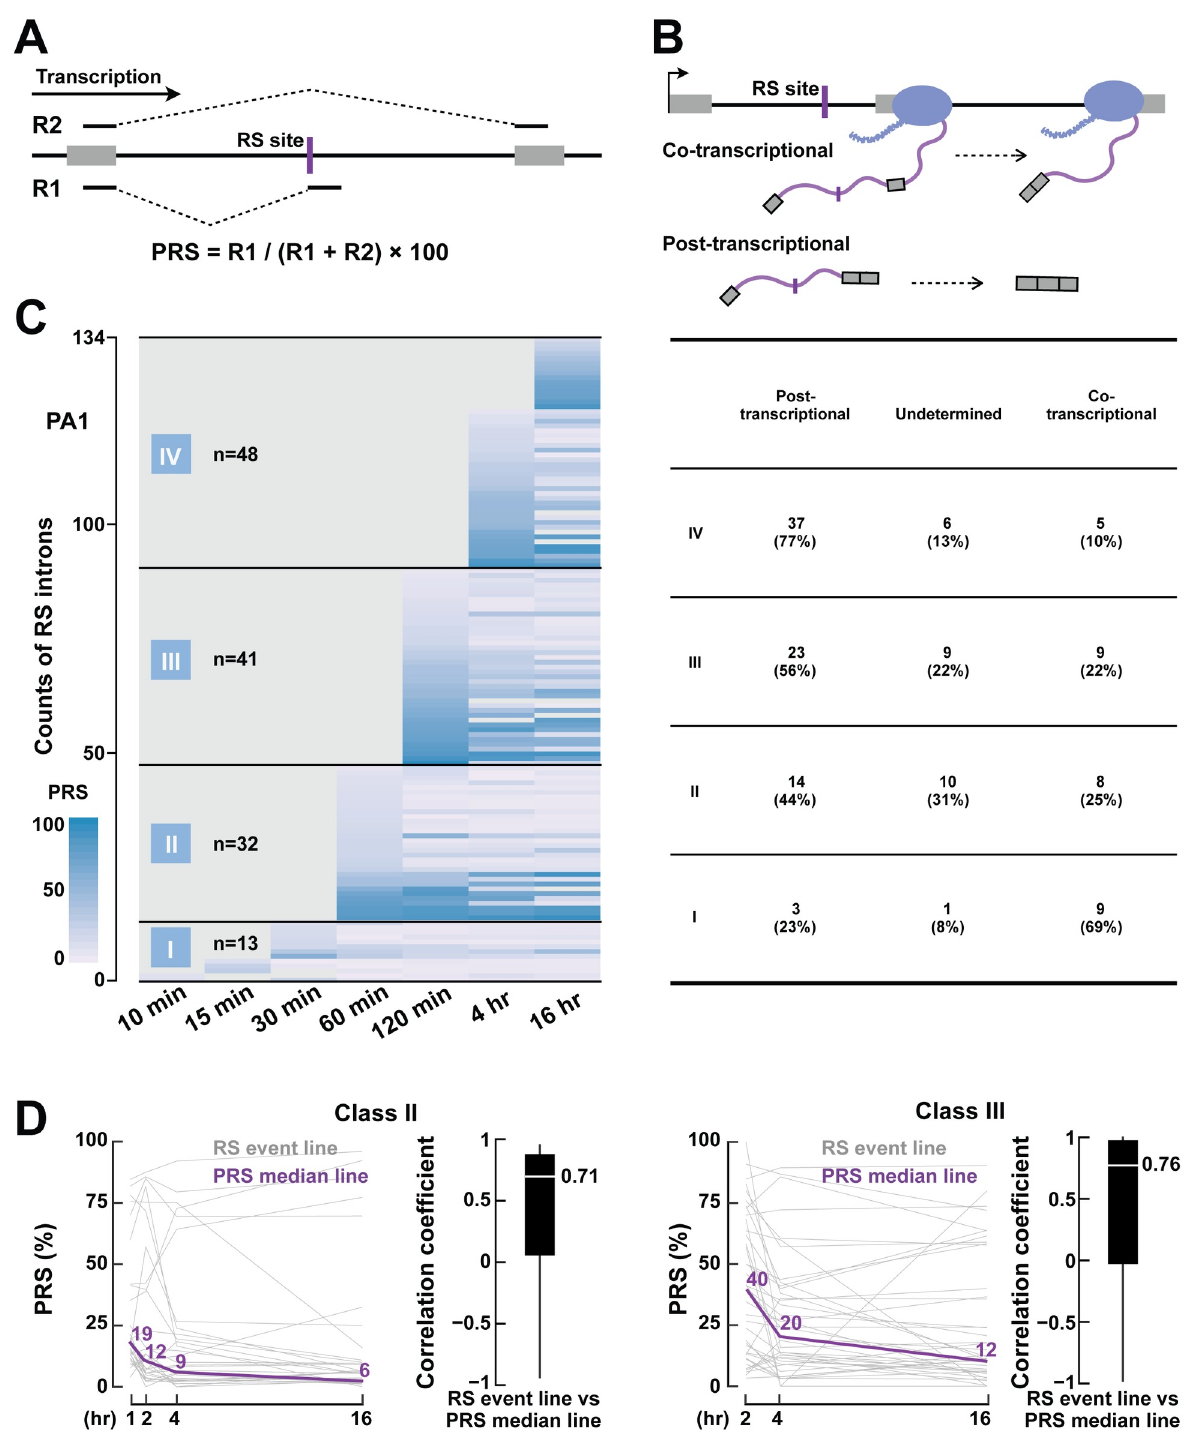
Fig 4. Recursive splicing occurs with a delay after transcription. (A) Percent Recursive Splicing (PRS) is defined as the percentage of junction reads that support the intermediate product of recursive splicing. (B) A schematic diagram to show the definition of co-transcriptional and post- transcriptional recursive splicing. For co-transcriptional recursive splicing, the recursive splicing finished before the entire gene was transcribed (top panel), while in post-transcriptional recursive splicing, recursive splicing started after the gene was transcribed (bottom panel). (C) The landscape of recursive splicing during transcription in PA1 cells. (Left) Each row is an RS event. All RS events are clustered into four classes according to their onset time for recursive splicing and sorted within each class by PRS. (Right) The table lists the counts and percentages of RS intron with post-